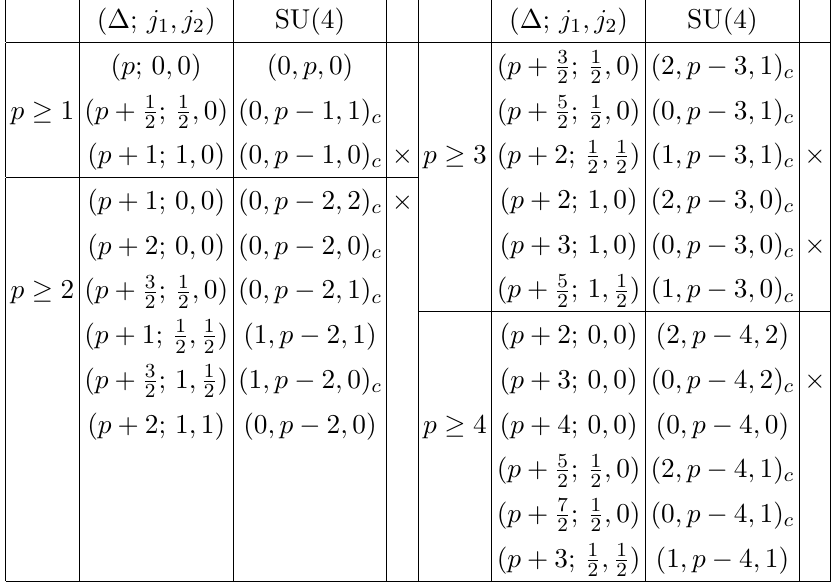
Table 1 . Multiplet content of compactification of type IIB supergravity on S 5 . Here ∆ is conformal dimension and ( a, b, c ) are Dynkin labels of SU(4) . We use the notation ( a, b, c ) c = ( a, b, c )+( c, b, a ) with a corresponding swap of ( j 1 , j 2 ) indices. A cross means that the corresponding mode originates from the 10d tensor which is a complex combination of the NS-NS and R-R rank 2 antisymmetric tensor fields cf.